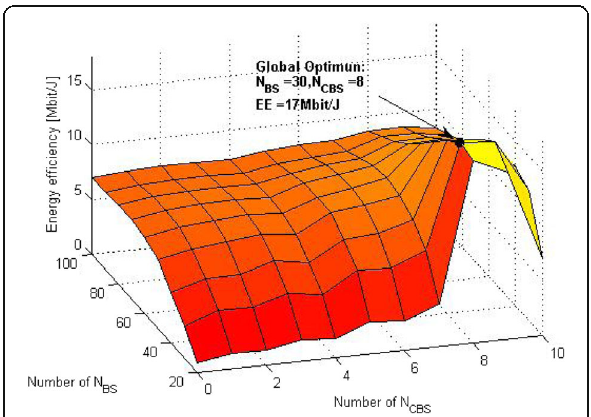
Fig. 3 EE with respect to N MBS with different coordination schemes,